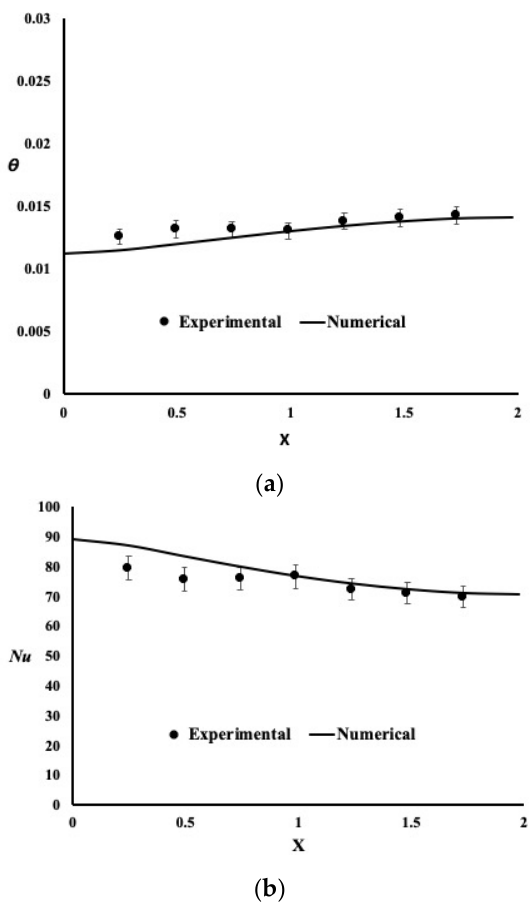
Figure 4. Comparison with experimental data for porous channels condition. ( a ) Temperature distribution, ( b ) Nusselt number variation.